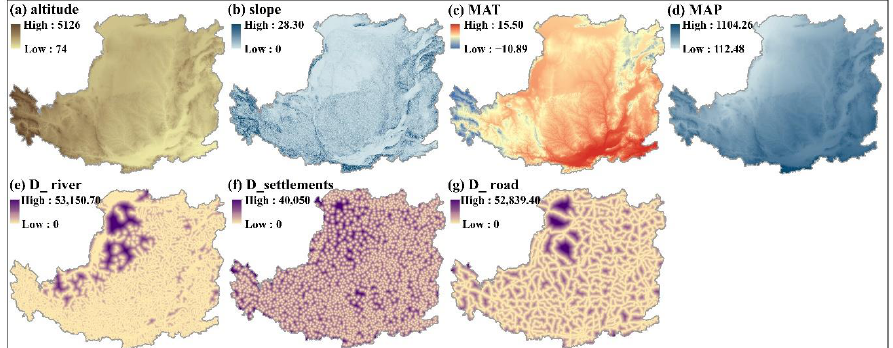
Figure 5. Spatial variations of topography ( a , b ), climate ( c , d ) and accessibility factors ( e – g ). MAT = mean annual temperature; MAP = mean annual precipitation; D_river = distance to the nearest river; D_settlements = distance to the nearest residential areas; D_road = distance to the nearest road. Remote Sens. 2019 , 11 , x FOR PEER REVIEW